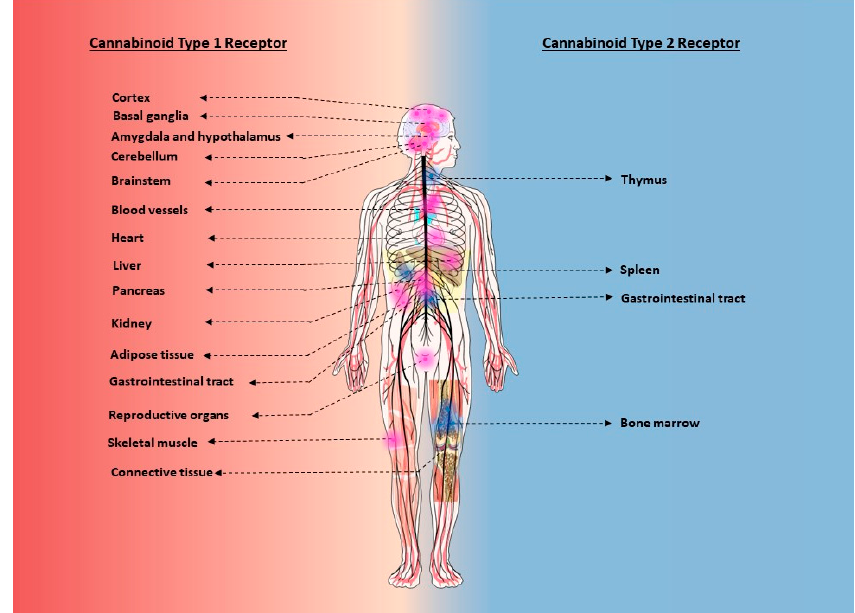
Figure 2. Tissue distribution of CB1R and CB2R under normal physiological conditions. The figure shows tissue expression of CB1R and CB2R under healthy conditions. Although CB1R protein or transcripts have been identified in several non-neural tissues, they are predominantly localized in the central nervous system (CNS). On the other hand, the CB2R is predominantly found in tissues involved in immune regulation. It is sparsely distributed in the CNS under normal physiological conditions.